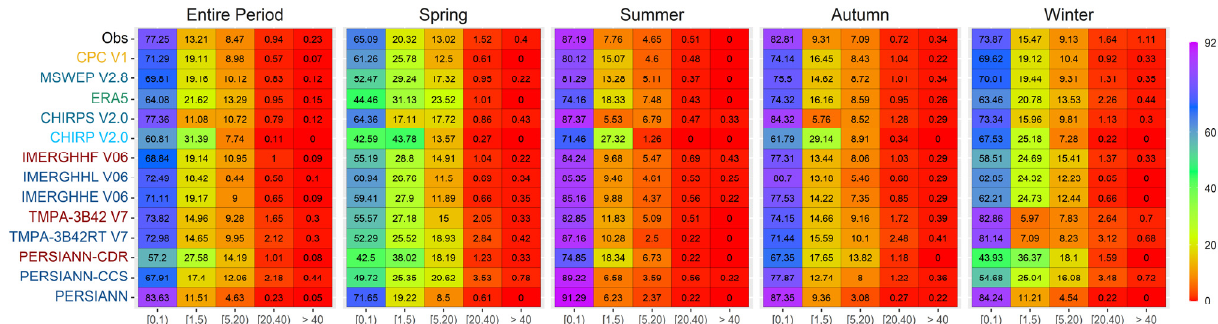
Figure 7. GPD Probability Density Function (PDF) for different daily precipitation intensities over the Karasu basin. Y-axis color presents: satellite-based (blue), gauge and satellite (red), reanalysis and satellite (sky blue), reanalysis (green), reanalysis, ground, and satellite (steel blue), and ground (yellow).